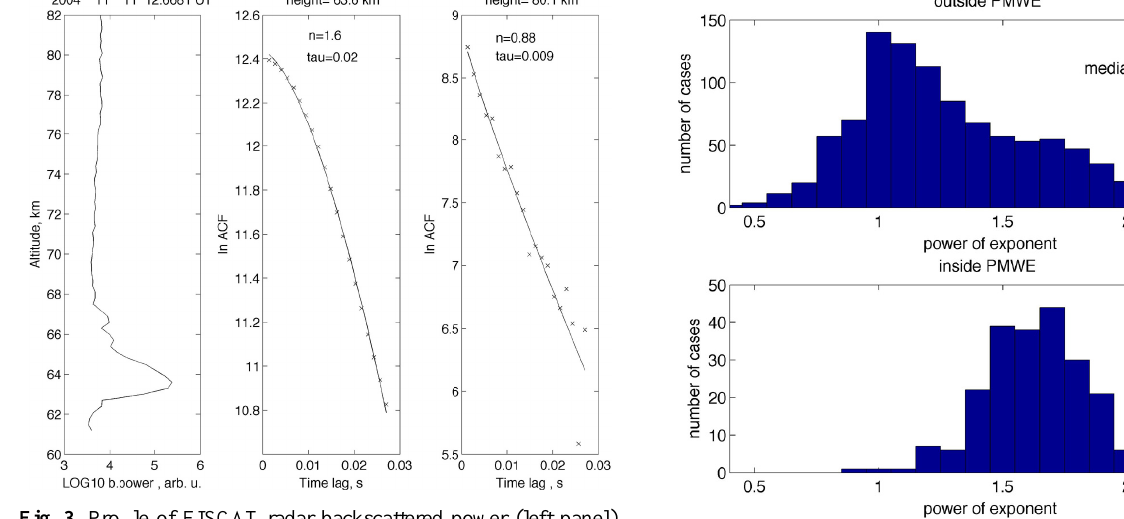
Fig. 3. Profile of EISCAT radar backscattered power (left panel), experimental (crosses) and fitted (solid line) ACFs at two altitudes: 63.6km (middle panel), where the maximum of PMWE power was observed, and 80.1km (right panel), where the EISCAT radar mea- sured background incoherent scatter. The parameters of fit: power of exponent n and decay time tau in seconds are shown in the panels.